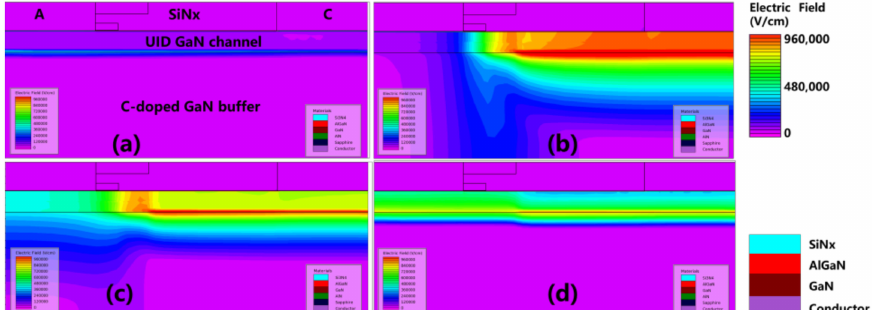
Figure 9. The electric field distribution at different timings. ( a ) t 0 : the initial state; ( b ) t 1 ; ( c ) t 2 ; and ( d ) t 3 .